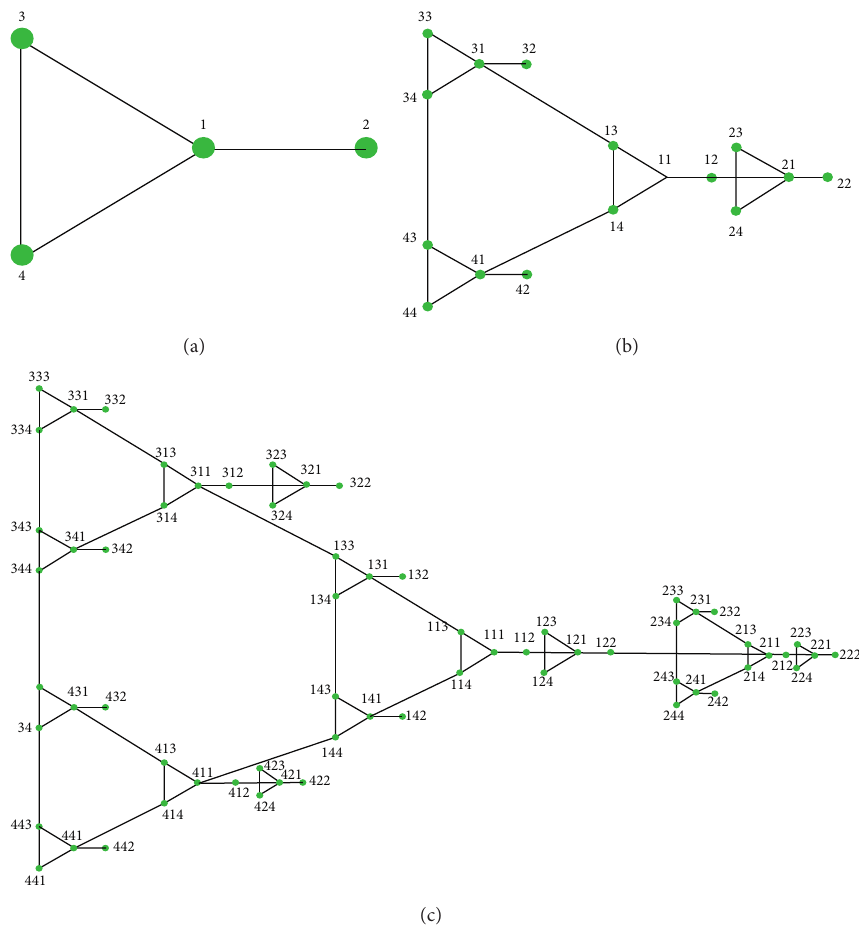
Figure 6: The generalized Sierpi´nski networks. (a) t � 1. (b) t � 2. (c) t �